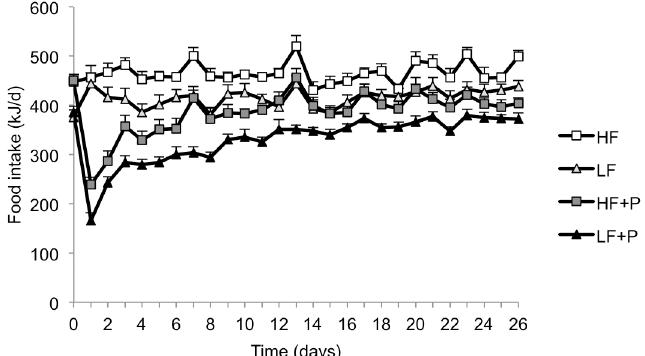
Fig 2. Food intake. Daily food energy intake by diet induced obese rats fed high fat diet (HF), high fat diet with 10% w/w pectin (HF+P), low fat diet (LF), or low fat diet with 10% w/w pectin (LF+P) for 4 weeks in two independently replicated experiments ( n = 16 per diet group). ANOVA revealed HF > LF > HF+P > LF+P ( P < 0.001).